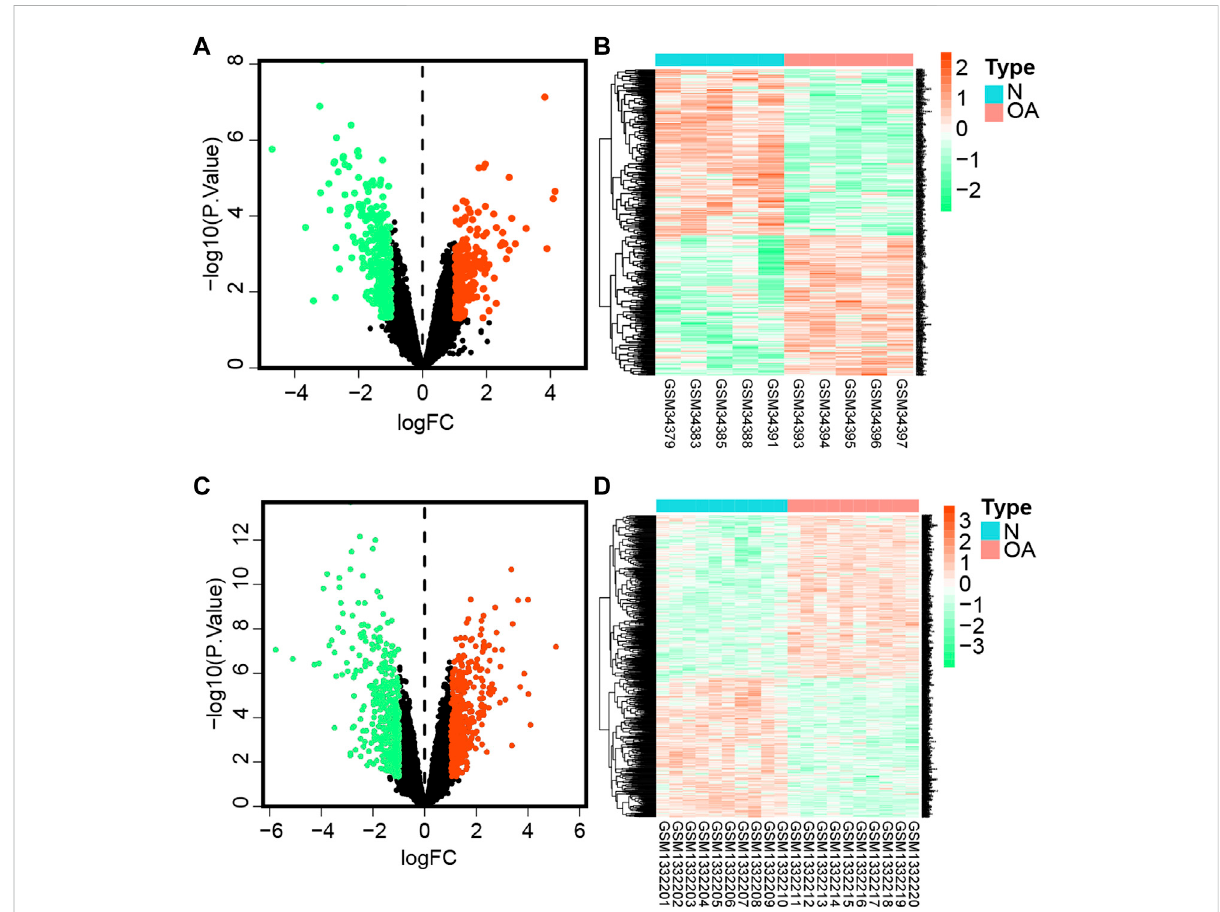
FIGURE 1 Differentially expressed genes. (A) Volcano plot of DEGs in the GSE1919 dataset. The green dot represents downregulated genes, gray represents genes with no signi fi cant difference, while the red dot represents upregulated genes comparing the OA group with the normal group in the GSE1919 dataset. (B) Heatmap represents hierarchical clustering for DEGs in the GSE1919 dataset. (C) Volcano map of DEGs in the GSE55235 dataset. (D) Heatmaps of DEGs in the GSE55235